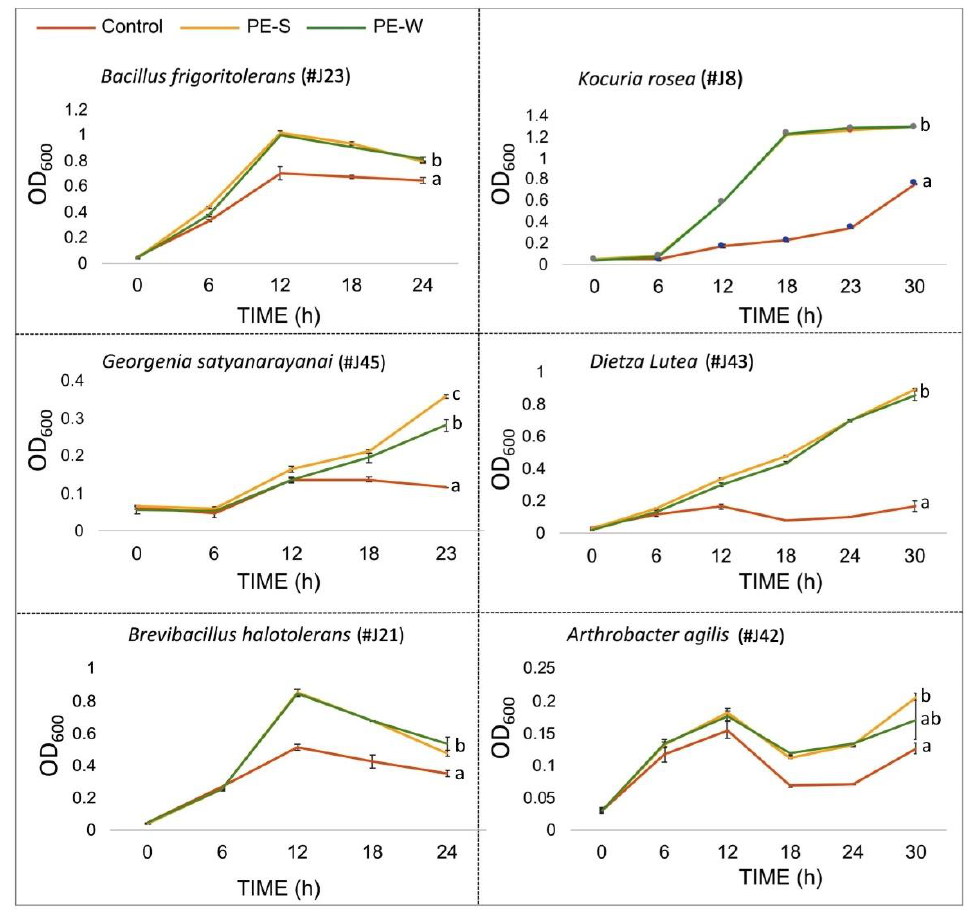
Figure 3. Petiole extracts (PEs) promote bacterial growth. The indicated bacteria were grown in a conical flask in NB (control, red line), or in NB supplemented with 10% of summer or winter PEs (PE-S, orange line; PE-W, green line). Bacterial growth was monitored by measuring the OD 600 of the culture every 6 h in a course of 23 – 30 h. Each treatment was performed in triplicates, and error bars represent the standard deviation. Statistical significance between treatments was determined for each endophyte by one-way ANOVA with Tukey test calculator, and different letters indicate statistically significant differences between treatments ( p < 0.01).